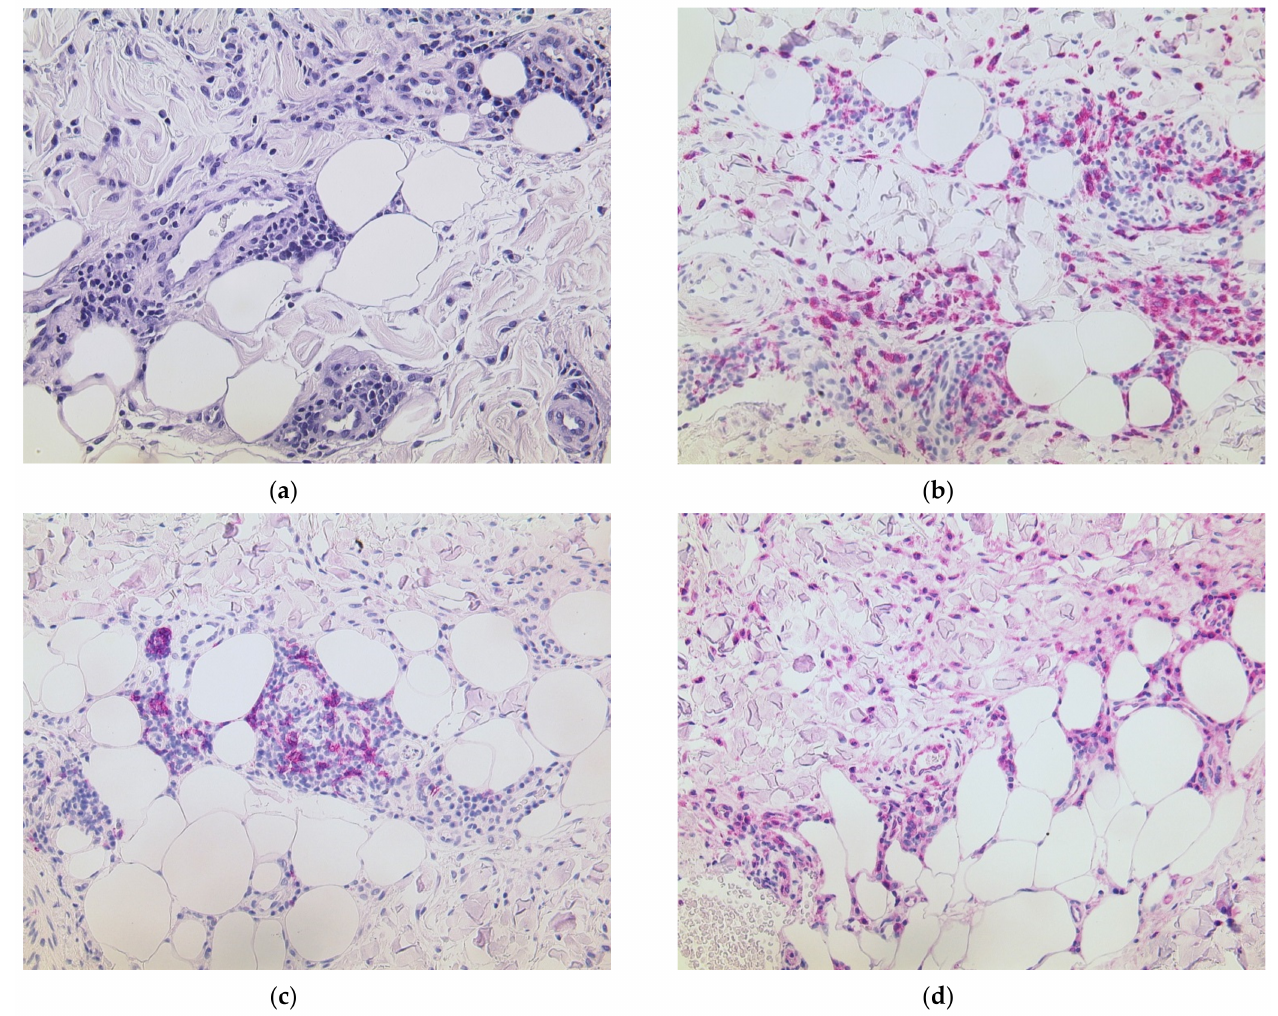
Figure 2. Histological findings of septal panniculitis. ( a ) Mixed inflammatory reaction involving the septae of the sub- cutaneous fatty tissue (HE, 200 × original magnification). ( b ) Abundance of histiocytes (CD68/PGM1, 200 × original magnification). ( c ) Abundance of B cells (CD20, 200 × original magnification). ( d ) Lesional expression of the type I/III interferon surrogate MxA (MxA, 200 × original